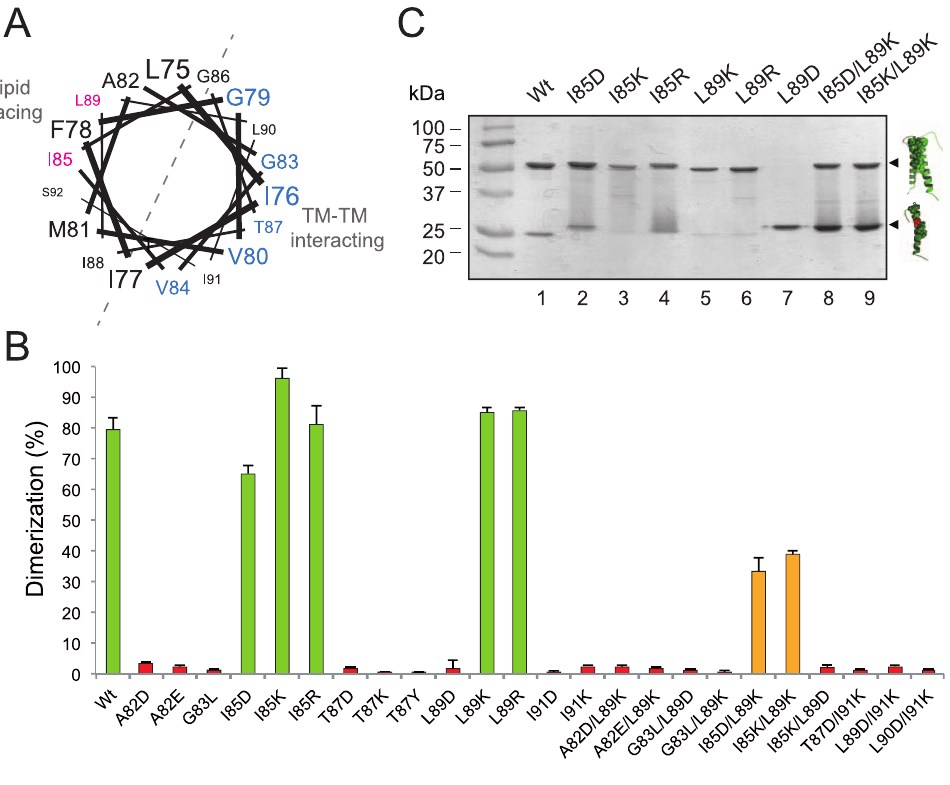
Figure 3. Dimerization in SDS micelles. (A) Helical wheel projection of GpA TM sequence. The residues associated with dimer formation as defined by Orzaez et al. [16] are shown in blue. Non-interacting residues susceptible of ionizable residue substitution are shown in magenta. (B) Green colored bars denoted dimerization levels similar to wild-type sequence. Bars for intermediate dimerization levels ( < 40%) are colored orange. Red colored bars denote non-dimerizing sequences (dimerization , 3%). (C) SDS-PAGE analysis of GpA mutants. Chimeric proteins were purified in the presence of SDS and analyzed by PAGE. Positions of the monomer and dimer of the chimeras are marked on the right as single and double helices, respectively.